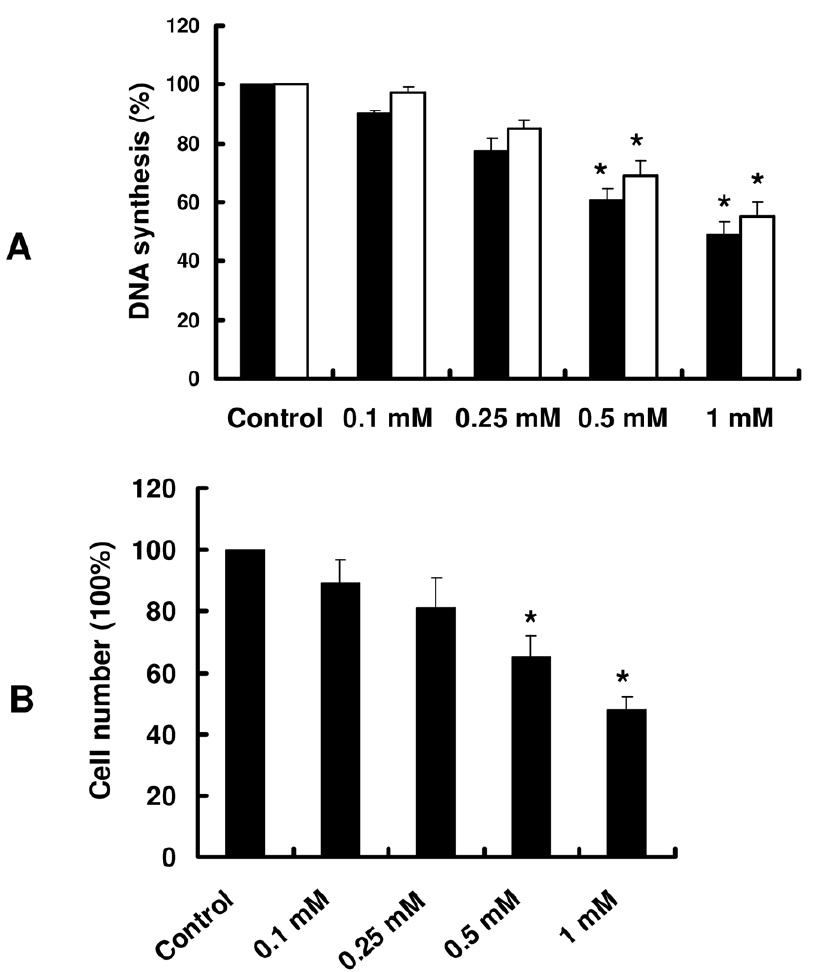
Figure 1. Homocysteine inhibits cell proliferation. Primary cultured hepatocytes or HepG2 cells were incubated with varying concentrations of homocysteine (Hcy). (A) The cell proliferation was assessed by [ 3 H]-thymidine incorporation into DNA after treatment with Hcy for 24 h. (B) HepG2 cells were counted in triplicate in a hemocytometer after 7 days of incubation with Hcy. Medium and Hcy were replaced every 2 days. These results are means 6 SD of five experiments. * P , 0.05 versus control (without